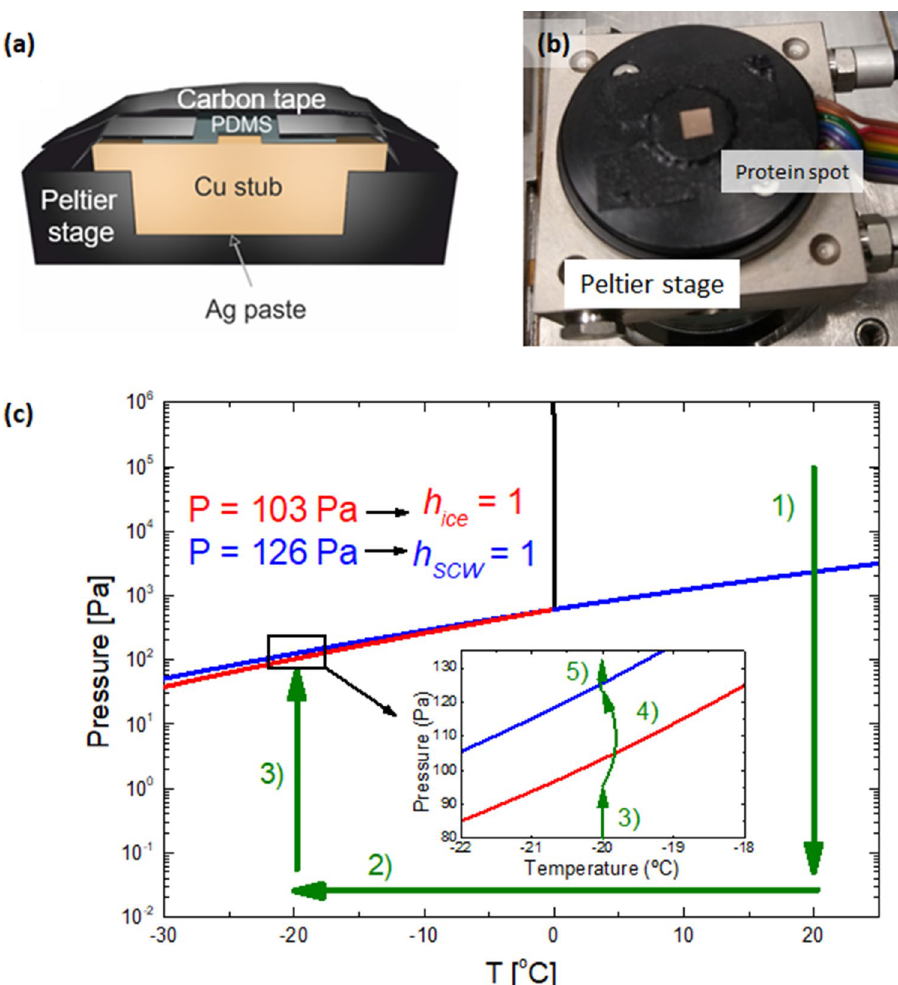
Figure 3. ( a ) Schematic overview and cross-section of Peltier stage prepared for ESEM experiments on SCW (not to scale). ( b ) Photograph of the Peltier stage with the copper stub (substrate surface). The red circle indicates the protein spot. ( c ) Zoom of the phase diagram of water. Green arrows indicate the protocol for deposition freezing experiments. P = 103 and 126 Pa correspond to pressure values to reach h ice = 1 and h SCW = 1, respectively, at − 20 °C. The numbers refer to the steps of the deposition freezing experiments (see text). Created with OriginPro 9.0 (www. origi nlab. com/) and CorelDraw (www. corel draw.